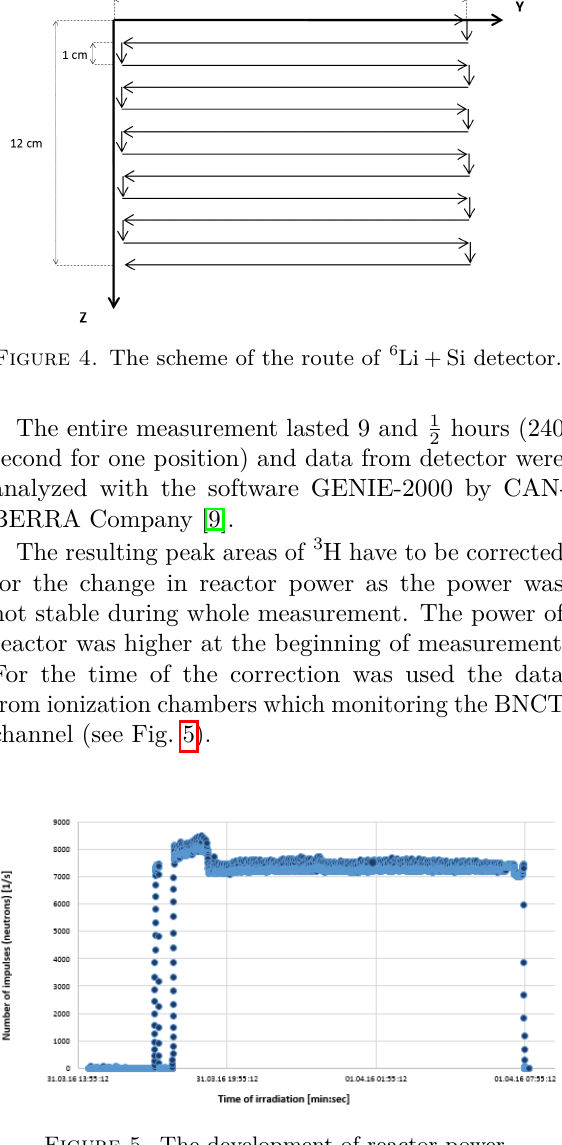
Figure 5. The development of reactor